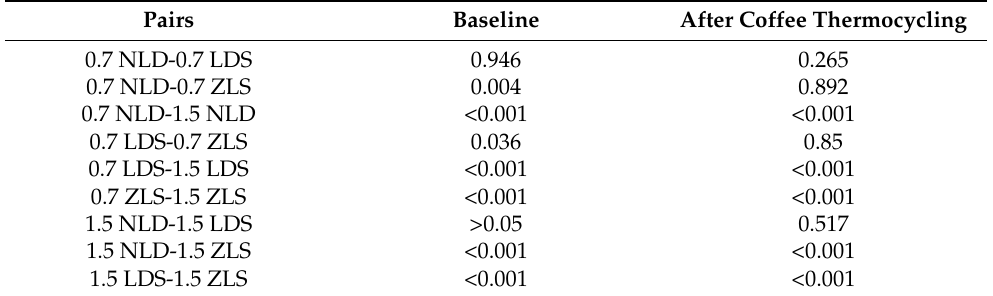
Table 4. Comparison of p values for RTP values of clinically relevant pairs at the baseline and after coffee.